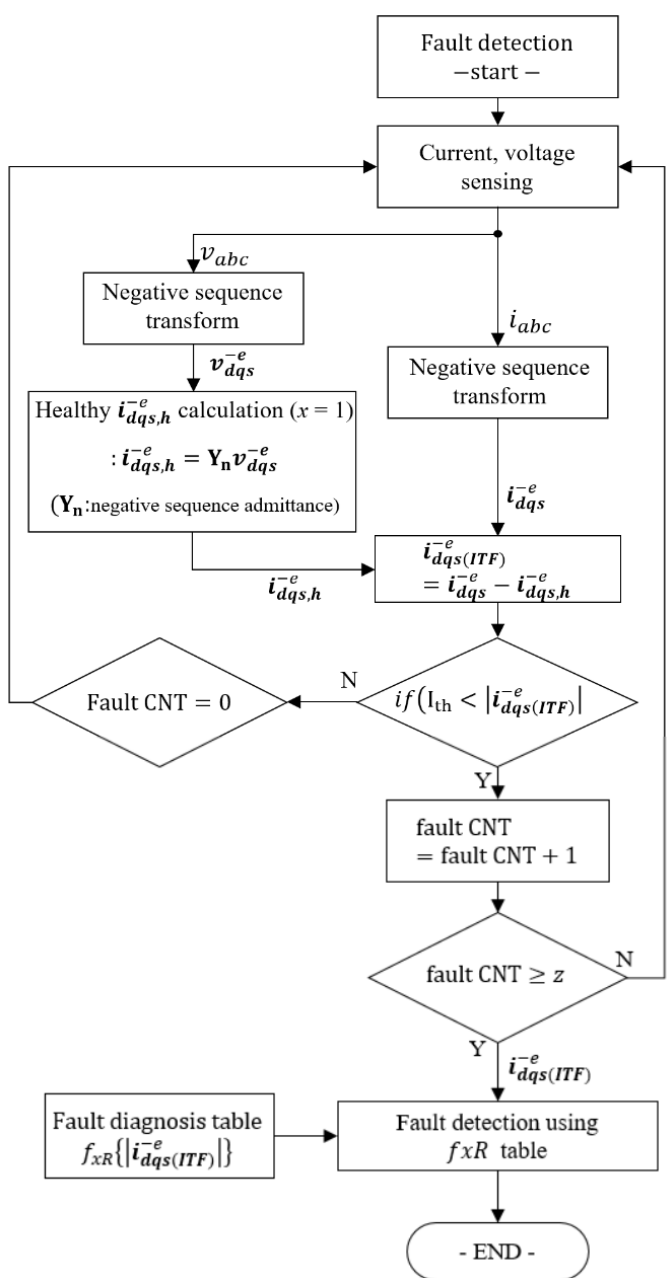
Figure 5. Block diagram of proposed ITF diagnosis and 𝑓 (cid:3051)(cid:3019) estimation method. To diagnose the ITF, 𝒊 𝒅𝒒𝒔(cid:2879)(cid:3032) is compared with the healthy negative sequence current 𝒊 𝒅𝒒𝒔,𝒉(cid:2879)(cid:3032) in real time. The negative sequence current that occurs additionally by the ITF can be expressed as 𝒊 𝒅𝒒𝒔(𝑰𝑻𝑭)(cid:2879)(cid:3032) = 𝒊 𝒅𝒒𝒔(cid:2879)(cid:3032) − 𝒊 𝒅𝒒𝒔,𝒉(cid:2879)(cid:3032) . In the method, I (cid:2930)(cid:2918) denotes the threshold level of the negative sequence current to detect an ITF. I (cid:2930)(cid:2918) is set to the maximum value of 𝒊 𝒅𝒒𝒔(𝑰𝑻𝑭)(cid:2879)(cid:3032) in the absence of ITFs. When (cid:3627)𝒊 𝒅𝒒𝒔(𝑰𝑻𝑭)(cid:2879)(cid:3032) (cid:3627) is greater than the threshold current I (cid:2930)(cid:2918) , the fault counter increases. However, if it is confirmed that the occurred negative sequence cur- rents were caused by a temporary error rather than an ITF, the fault counter is initialized